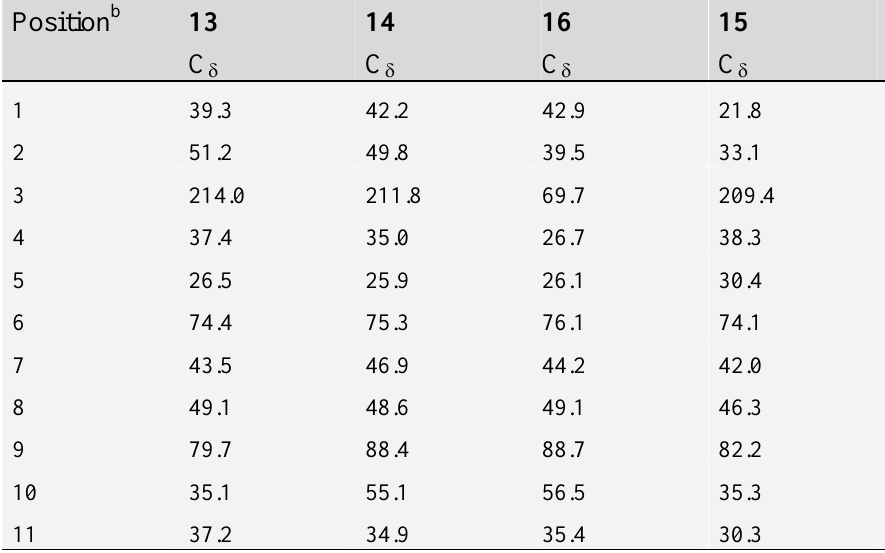
) spectral data of the compounds 13 , 14 , 15 and 16 a 3